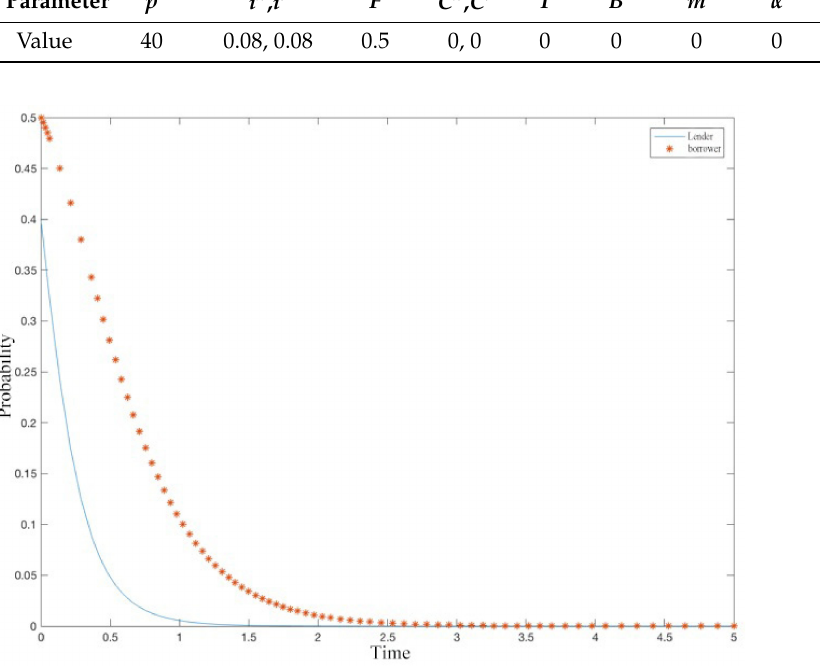
Figure 5. The dynamic evolutionary processes of inactive online lending platforms.